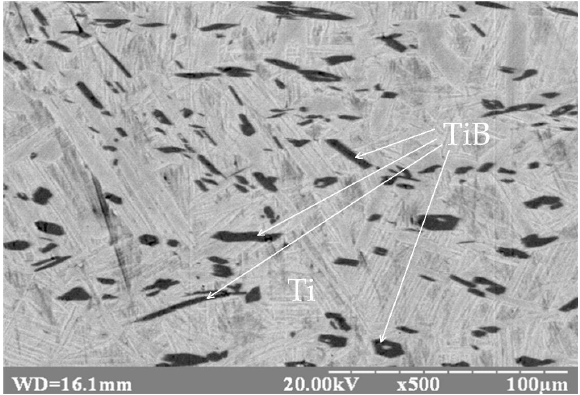
Figure 1. Structure of Ti-TiB melt before welding.